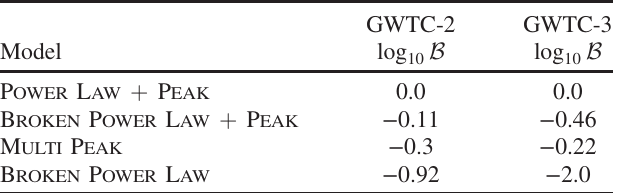
TABLE XV. Bayes factors for each of the previously used phenomenological mass models relative to the model with highest marginal likelihood, P OWER L AW +P EAK . The previous results from GWTC-2 are shown in the second column with the updated catalog results in the third column.